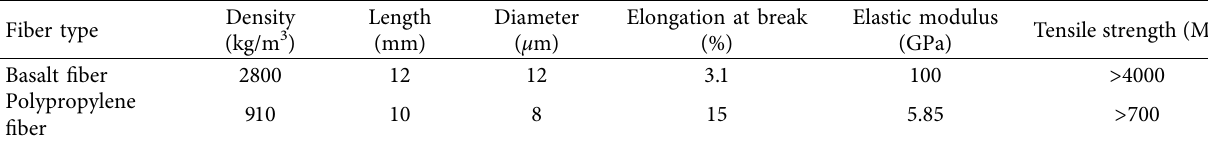
Table 2: Fiber performance index.